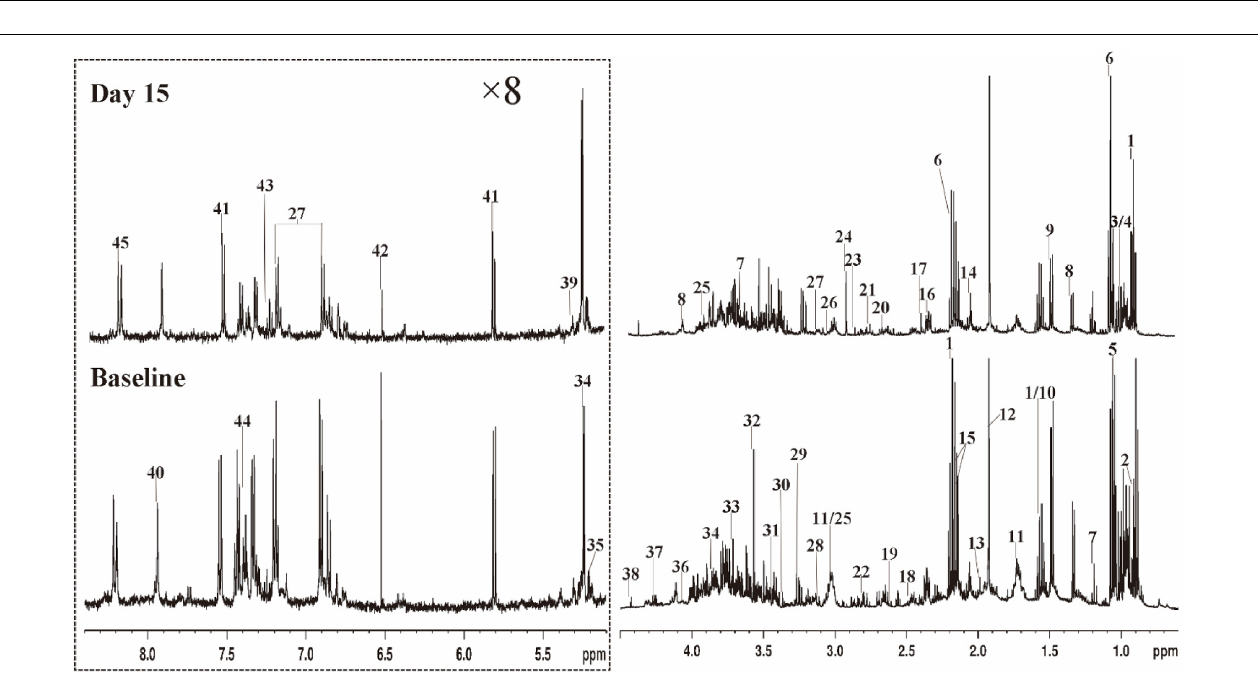
FIGURE 3 | Typical 500 MHz 1 H NMR spectra of fecal extracts for a volunteer with Baseline and Day 15. The spectra in the region ( δ 5.0–8.4) were vertically expanded by 8 times compared with the region ( δ 0.5–4.6). 1 butyrate; 2 a-ketoisocaproate; 3 isoleucine; 4 leucine; 5 valine; 6 propionate; 7 ethanol; 8 lactate; 9 alanine; 10 citrulline; 11 lysine; 12 acetate; 13 proline; 14 N-acetylglutamic acid; 15 methionine; 16 glutamate; 17 succinate; 18 glutamine; 19 methylamine; 20 aspartate; 21 dimethylamine; 22 asparagine; 23 trimethylamine; 24 N.N-dimethylglycine; 25 creatine; 26 creatinine; 27 tyrosine; 28 histidine; 29 β -glucose; 30 methanol; 31 taurine; 32 glycine; 33 glycerol ; 34 α -glucose; 35 α -xylose; 36 choline; 37 threonine; 38 1.3-dihydroxyacetone; 39 α -arabinose; 40 xanthine; 41 uracil; 42 fumarate; 43 3-hydroxyphenylacetic acid; 44 phenylalanine; 45 hypoxanthine.